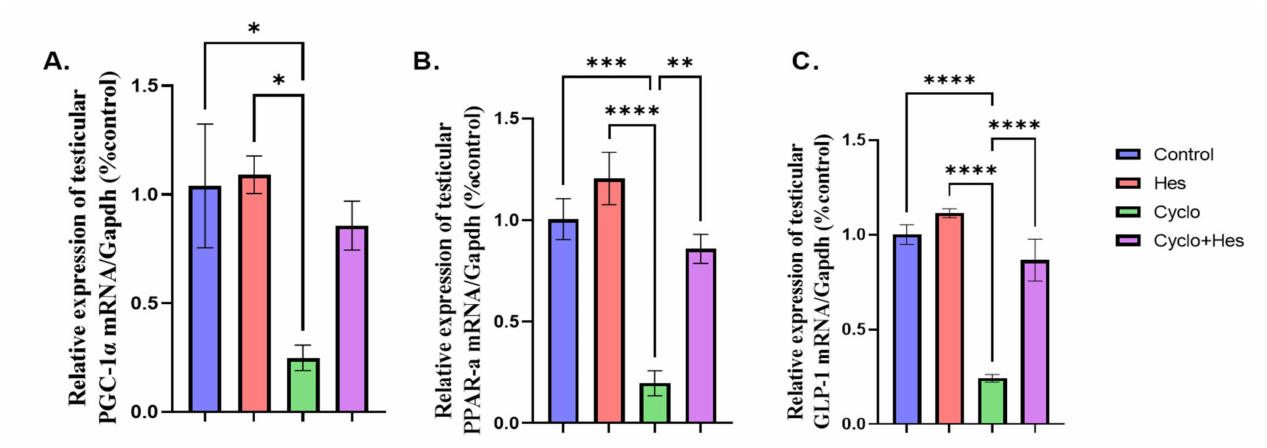
Figure 6. Effect of hesperidin administration in cyclophosphamide-induced testicular impairment in male rats on mRNA expression of testicular GLP-1, PGC-1, and PPAR-a ( A – C ). ( A ) Testicular PGC-1/Gapdh (% control), ( B ) mRNA expression of testicular PPAR-a/Gapdh (% control), and ( C ) mRNA expression of testicular GLP-1/Gapdh (% control). Data are expressed as means ± SEM. *, **, ***, **** indicate significant difference ( p < 0.05).